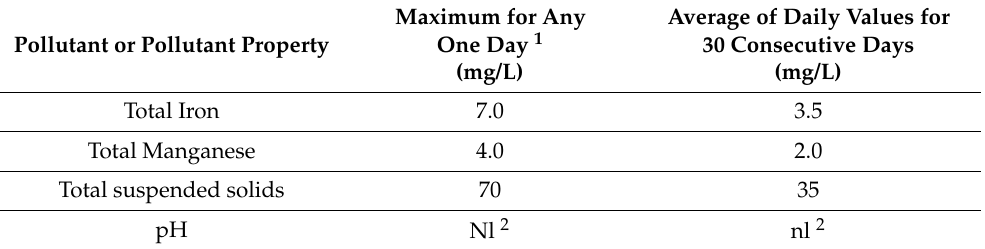
Table 1. EPA limitations for the concentration of discharged pollutants by coal preparation plants